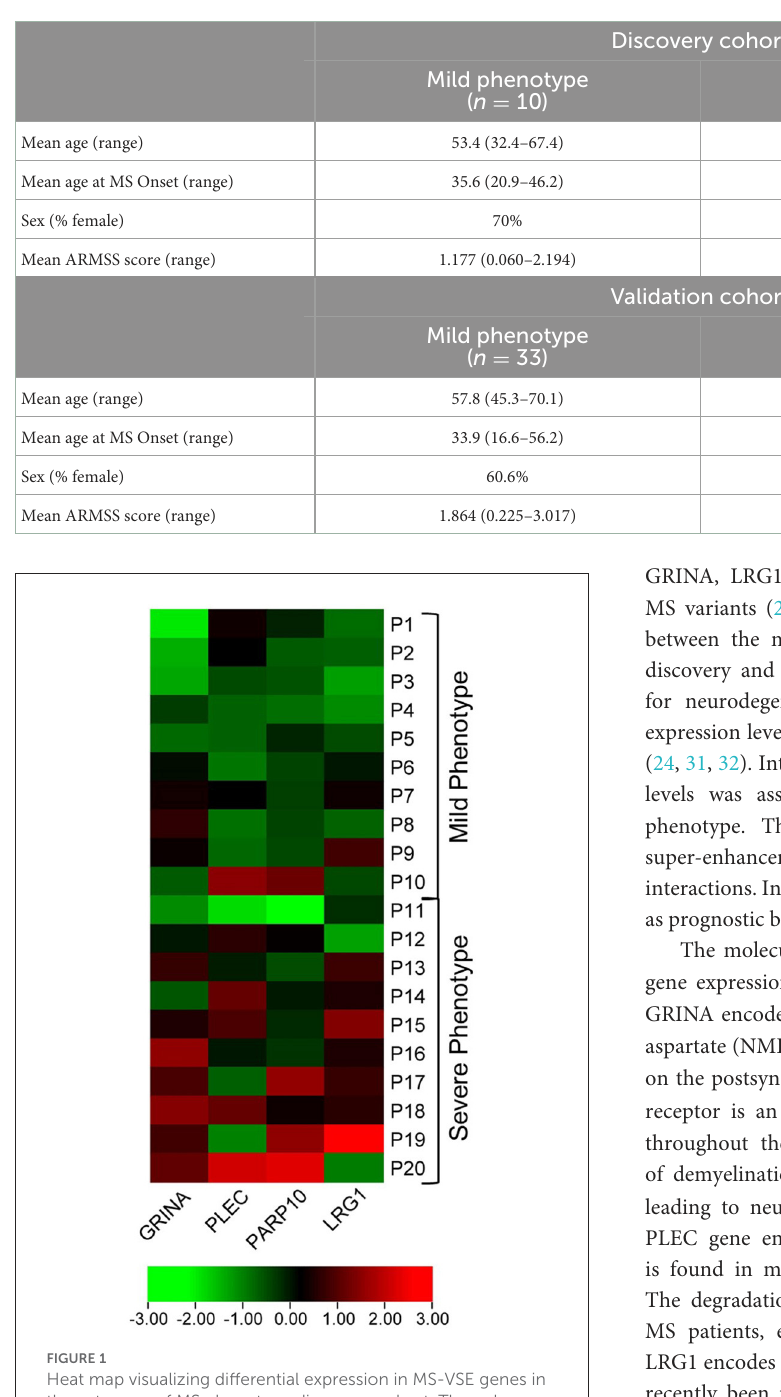
TABLE 1 Clinical characteristics of included study participants.